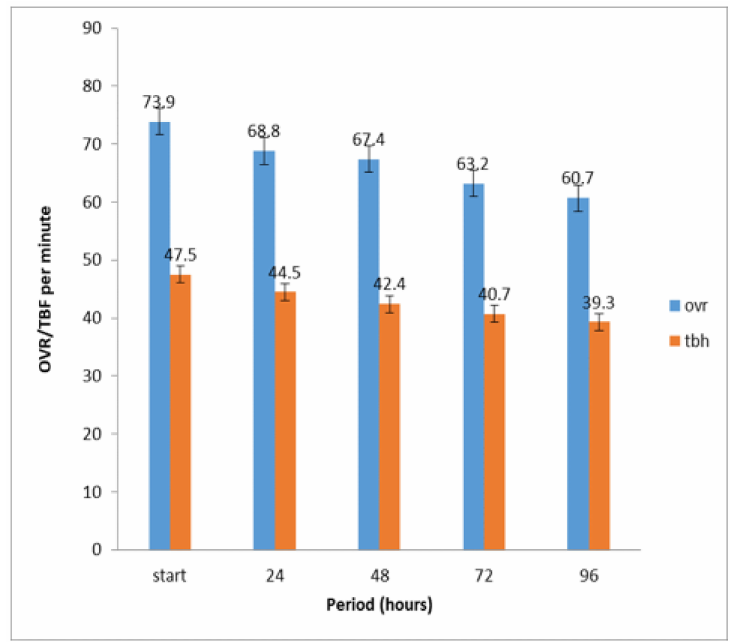
Figure 2. Mean OVR/TBF of exposed fish on acute doses of NTL.